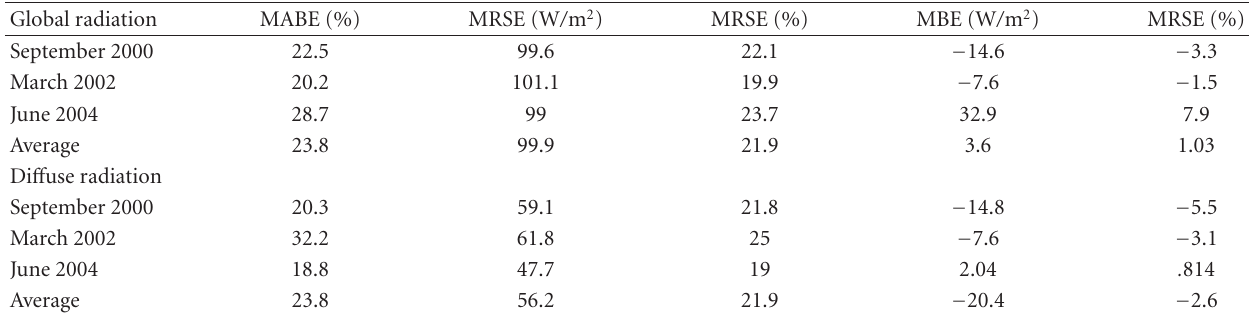
Table 2: Evaluation statistics for FFNN.